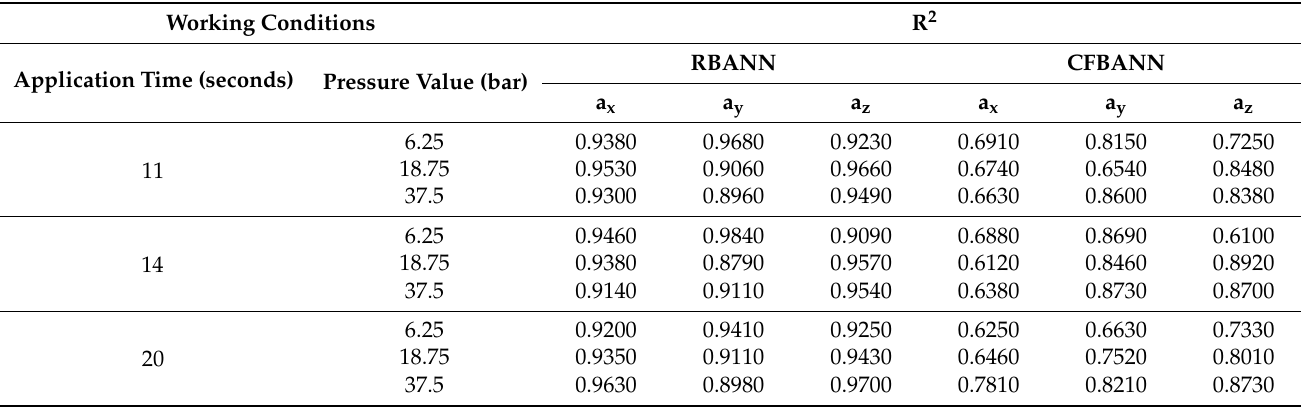
Table 5. Experimental working conditions and R2 values obtained in the x , y , and z